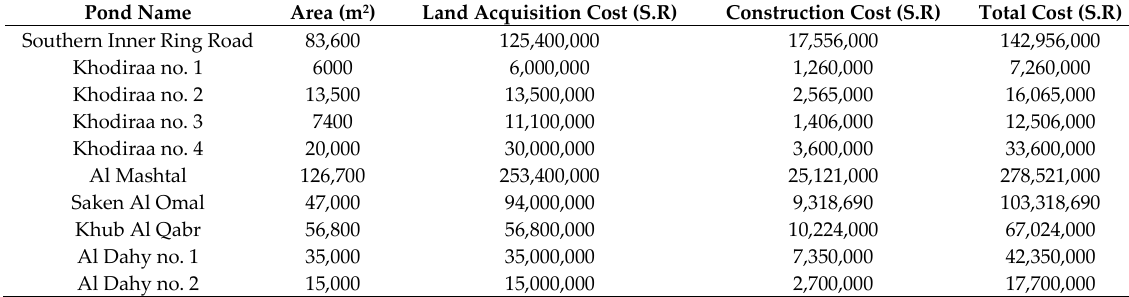
Table A4. Cost of land acquisition and construction for